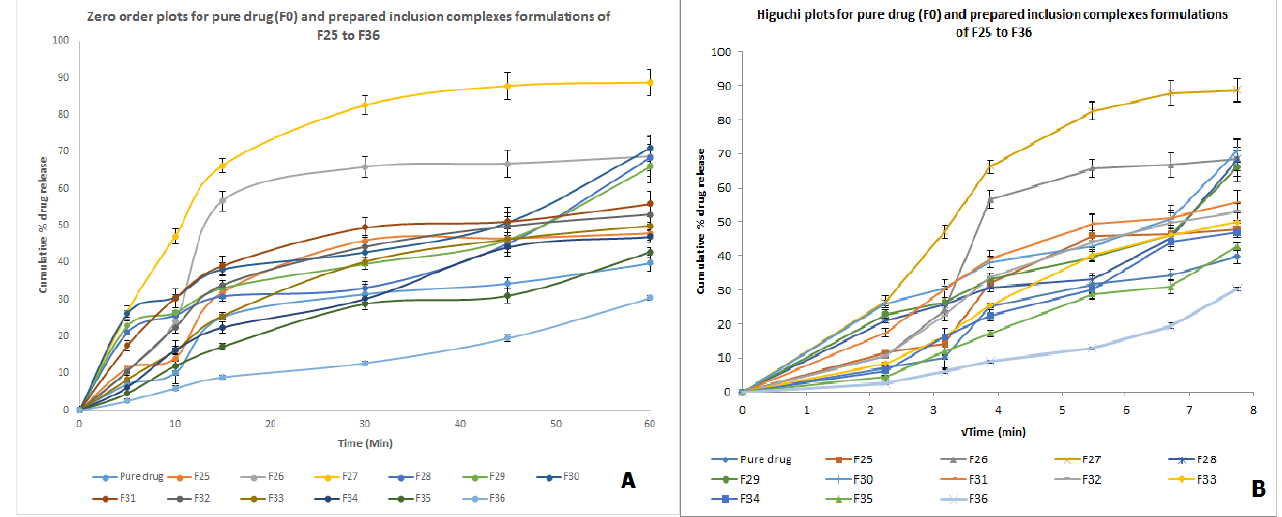
FIGURE 6 - Zero order plot for pure drug (F0), inclusion complexes and polymers dispersions (F25 to F36) [A]; and Higuich order plot for pure drug (F0) inclusion complexes and polymers dispersions (F25 to F36) [B] by co-evaporation method. TABLE VII - In-vitro dissolution kinetics data of inclusion complex of selected formulations Zero order Formulation code